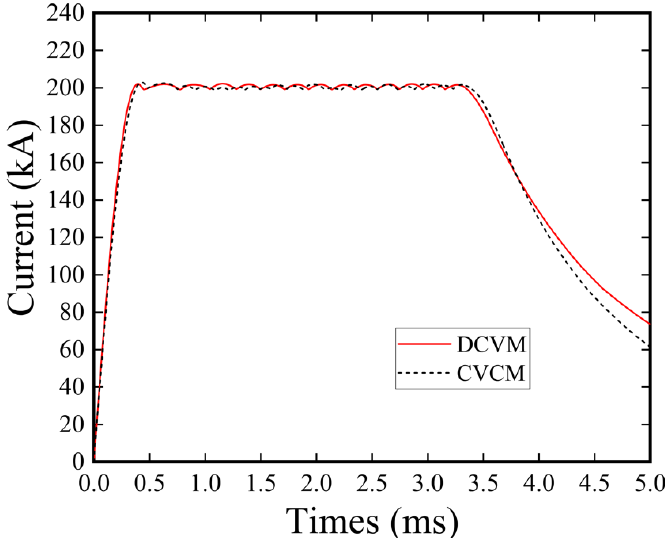
Figure 7. The contrast curve of current obtained with the two charging methods.